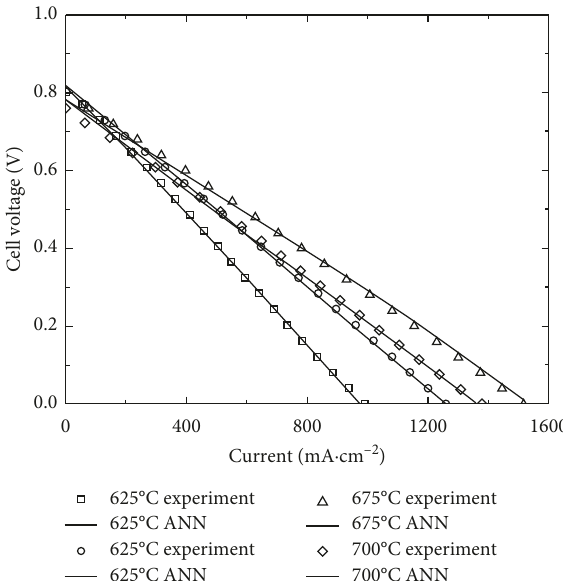
Figure 5: Comparison of I - V curves for the cathode sintered at 1000 ° C and operated at different temperatures by the ANN model and experimental data.